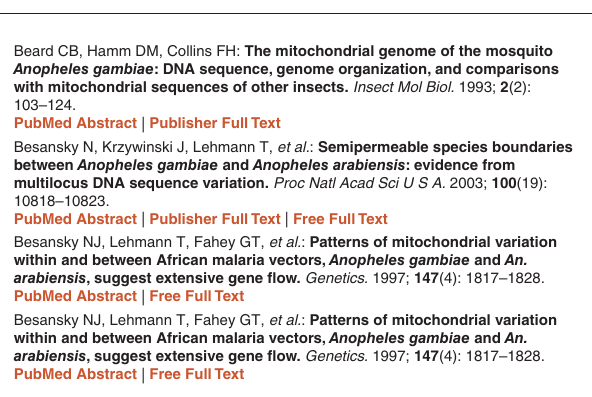
Supplementary Table S1. List of SNP variants in the different Anopheles species and chromosomal forms. Click here to access the